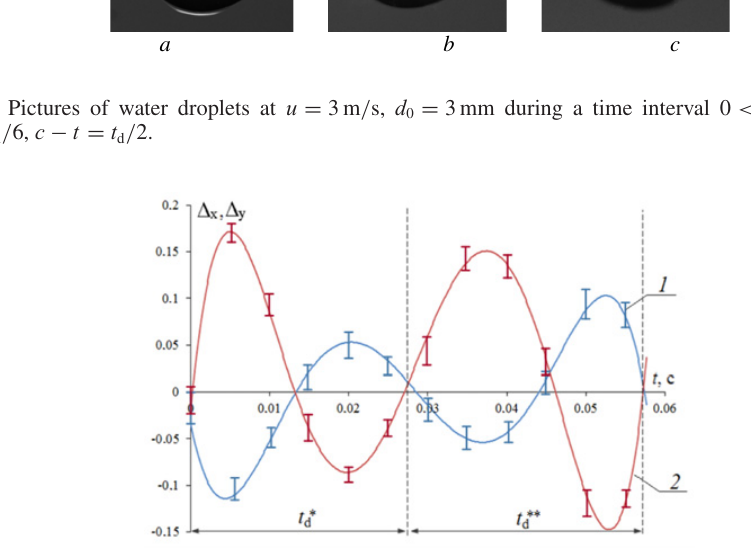
Figure 3. (cid:1) x and (cid:1) y values at u = 1.5m/s and d 0 = 4mm during several characteristic “deformation cycles”: 1 – (cid:1) (cid:1) x , 2 – y , * – first “deformation cycle” under consideration, ** – second “deformation cycle” under consideration.